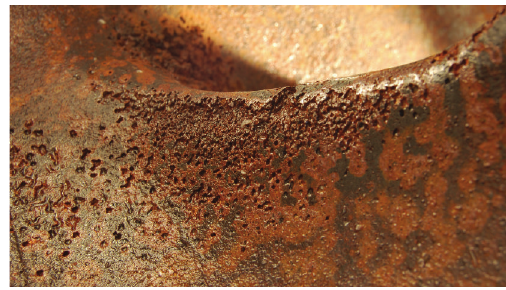
Figure 2: Cavitation erosion at single-vane impeller.